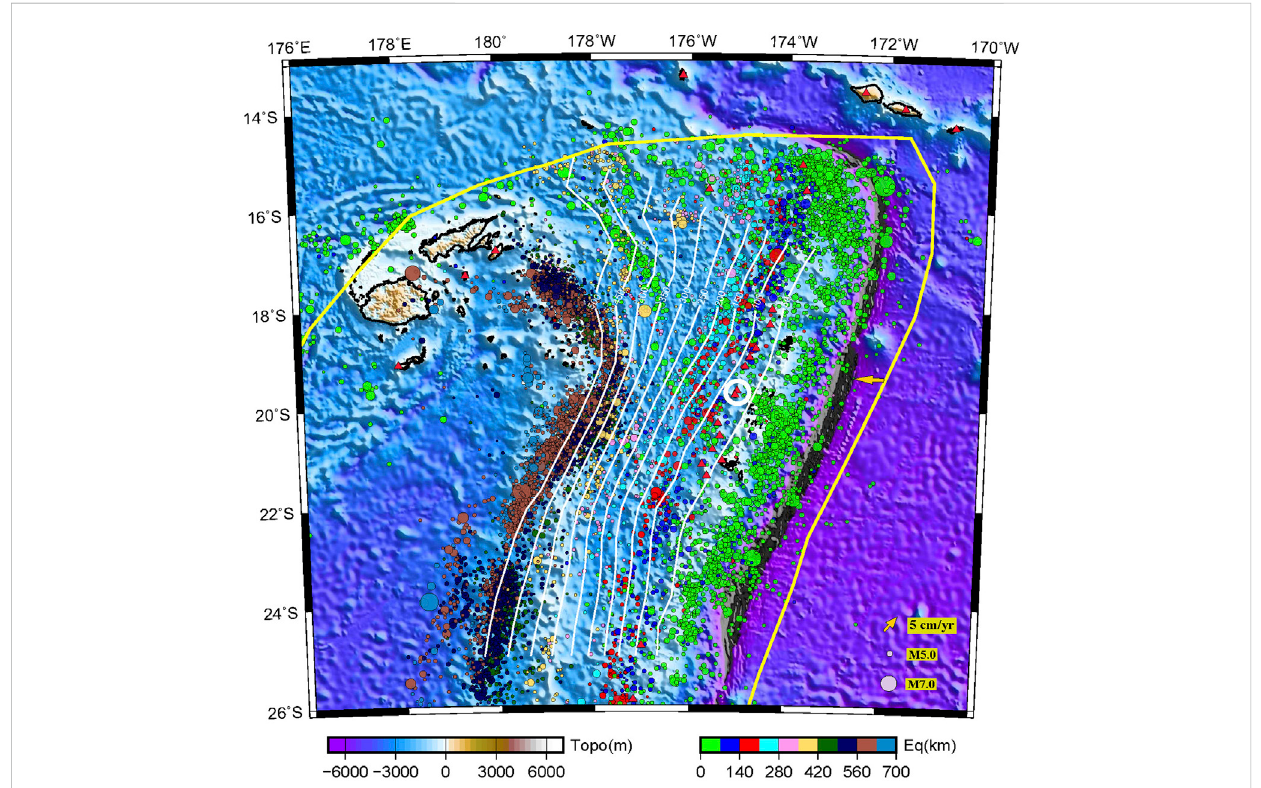
FIGURE 1 Platetectonicbackgroundwithearthquake(coloredcircles)andvolcanic(redtriangles)distributionsintheTongasubductionzone.Thewhitecircle indicatesthelocationoftheHTHHvolcano.Whitecurvesrepresenttheiso-depthcontoursofthesubductedplateuppersurfaceintheTonga-Kermadec arc (Slab2). Yellow arrows indicate the plate subduction velocities (cm/yr). The yellow line denotes the plate